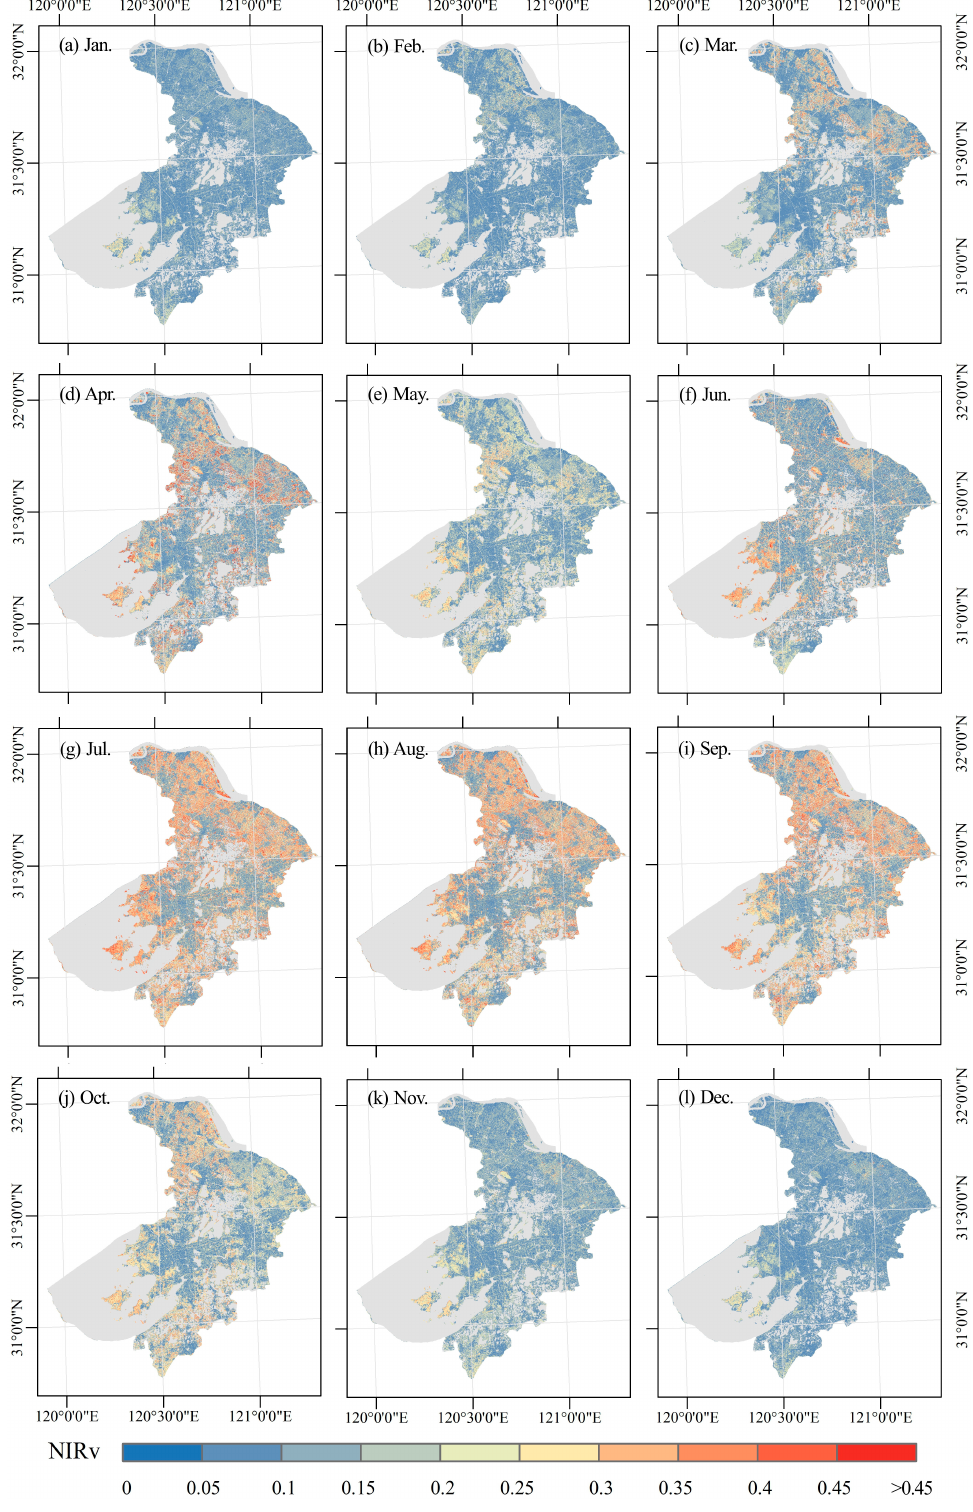
Figure 2. Spatial distribution of monthly Sentinel-2 NIRv in 2021, Suzhou. For comparing the differences of NIRv derived from MODIS, Landsat-8 and Sentinel-2, the monthly averages and standard deviations of NIRv were listed in Figure 3. Sentinel-2 NIRv showed two peaks in April and July, with values of 0.13 and 0.18, respectively. The values of MODIS NIRv were generally lower than Sentinel-2 and had similar trends